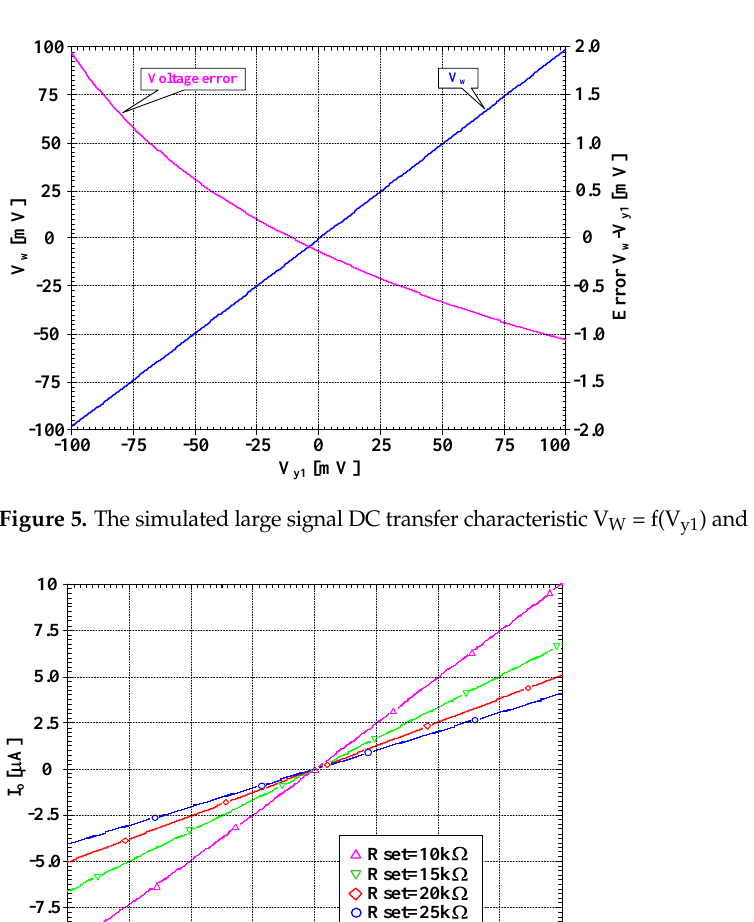
Sensors 2022 , 22 , x FOR PEER REVIEW